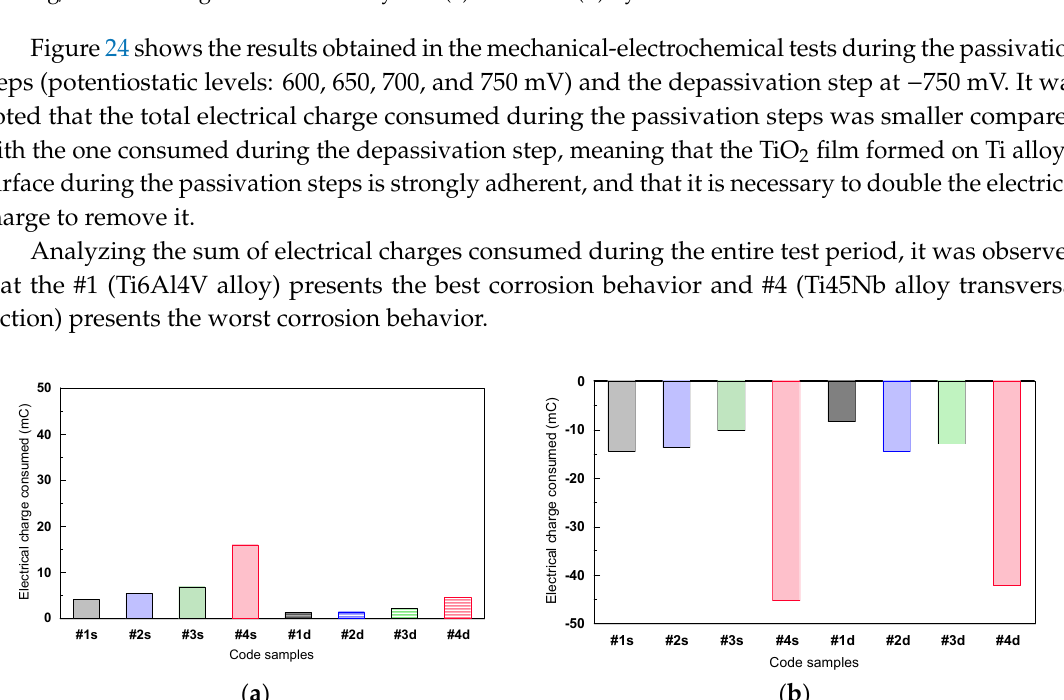
Figure 23. The fatiguecorrosion behavior of Ti45Nb alloy (longitudinal and transversal sections) in 9 g/L NaCl during the mechanical cycles: ( a ) static and ( b ) dynamic.